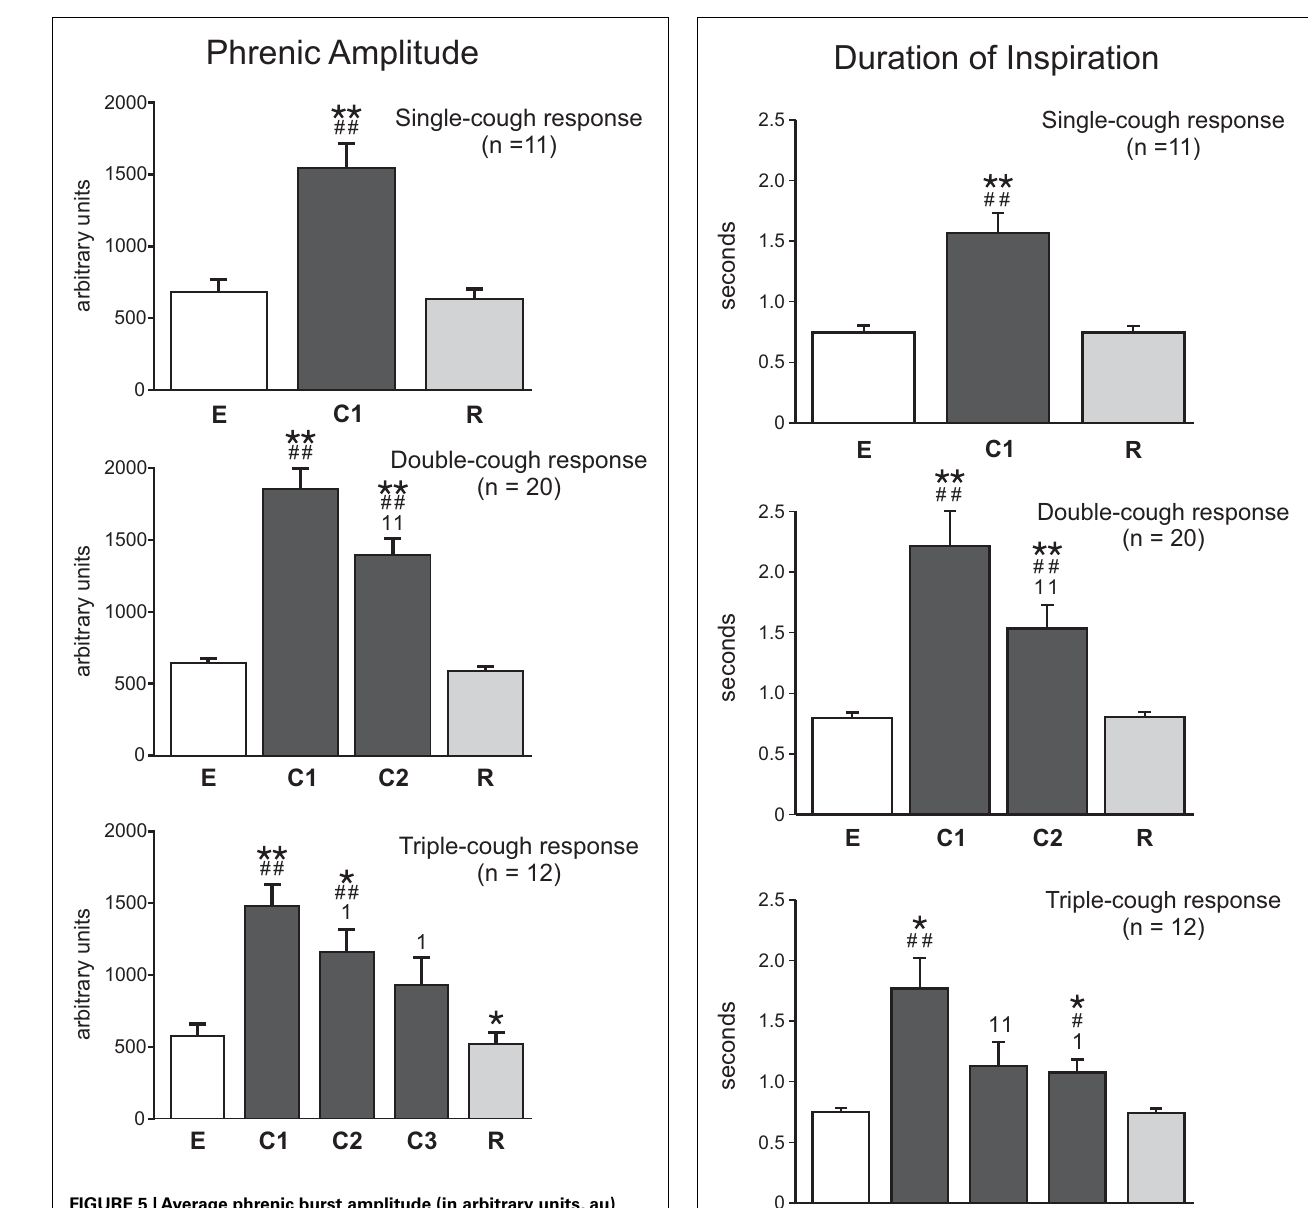
FIGURE 5 |Average phrenic burst amplitude (in arbitrary units, au) during single-, double-, and triple-cough episodes (top, middle, and bottom panels, respectively). Values for a given cough cycle (e.g., C1) were not different among these three cough response types. *Significantly different from E; #, significantly different from R; 1, significantly different from C1. P -values are indicated by one ( p < 0.02) or two ( p < 0.001) symbols. Error bars indicate the standard error of the mean.